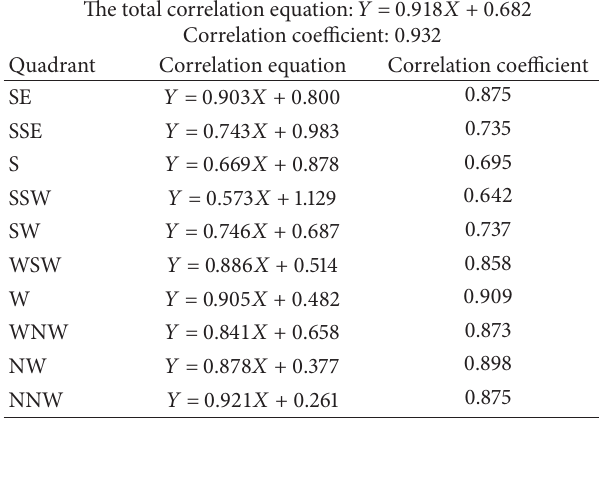
Table 3: Correlation coefficient of three meteorological stations.